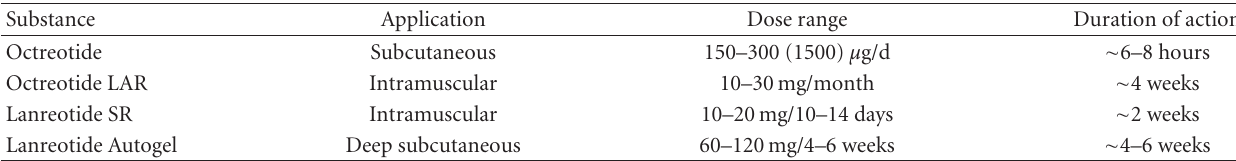
Table 1: Dosage and duration of action of di ff erent